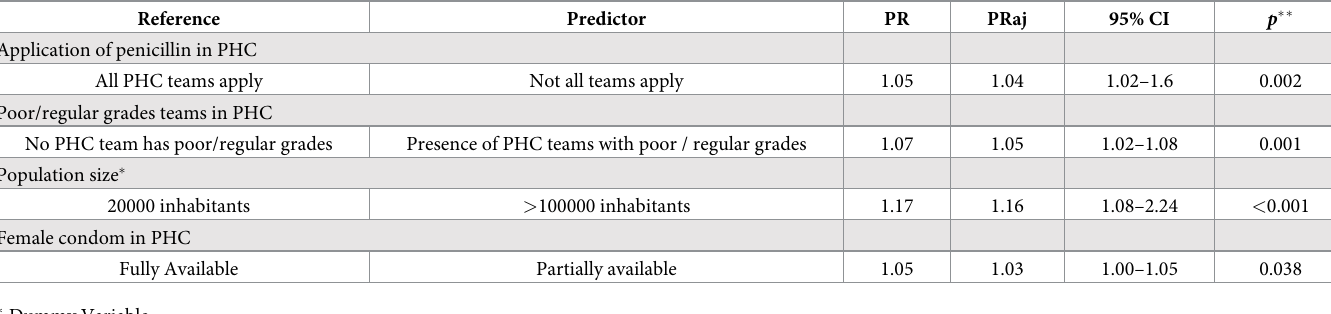
Table 4. Independent AAPC-related factors of the growing